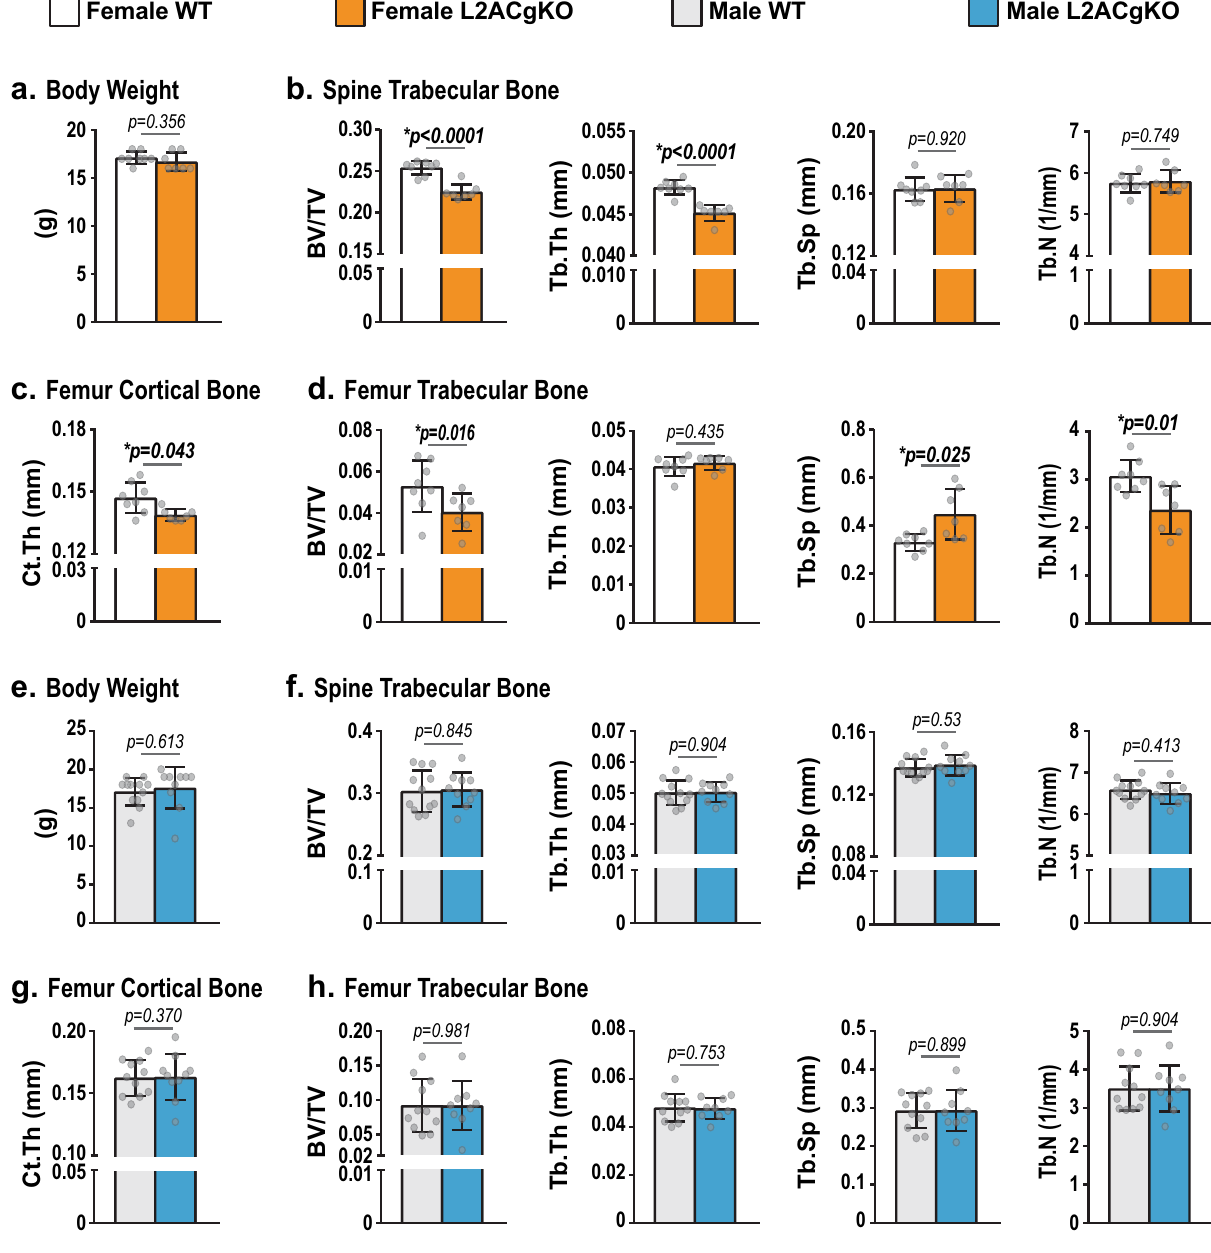
Figure 2. Skeletal analysis of growing L2ACgKO mice. (a–h) Body weight measurements ( a,e ) and μCt analysis was performed on bones of 5-week-old female ( a–d ) and male ( e–h ) Lamp2AC global knock-out (L2ACgKO) mice and their wild-type (WT) littermates. ( b,f ) Cancellous bone mass and architecture were analyzed as bone volume over tissue volume (BV/TV), trabecular thickness (Tb.Th), trabecular spacing (Tb.Sp), trabecular number (Tb.N) in lumbar vertebrae 4. ( d,h) Femoral cancellous bone mass and architecture were analyzed in the distal femur. ( c,g ) Femoral cortical thickness (Ct.Th) was measured at the midshaft. n = 7–12 mice/group. Bars indicate mean ± STDEV. p values were calculated and evaluated by Welch’s t -test; *, p <